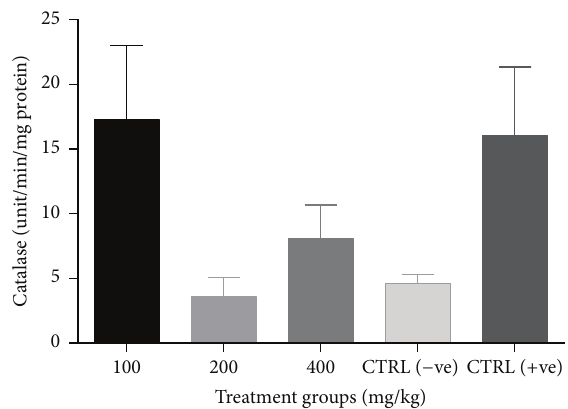
Figure 3: Effect of combined extracts of Azadirachta indica and Khaya senegalensis on catalase activity in the intestine of chickens infected with Eimeria oocysts.